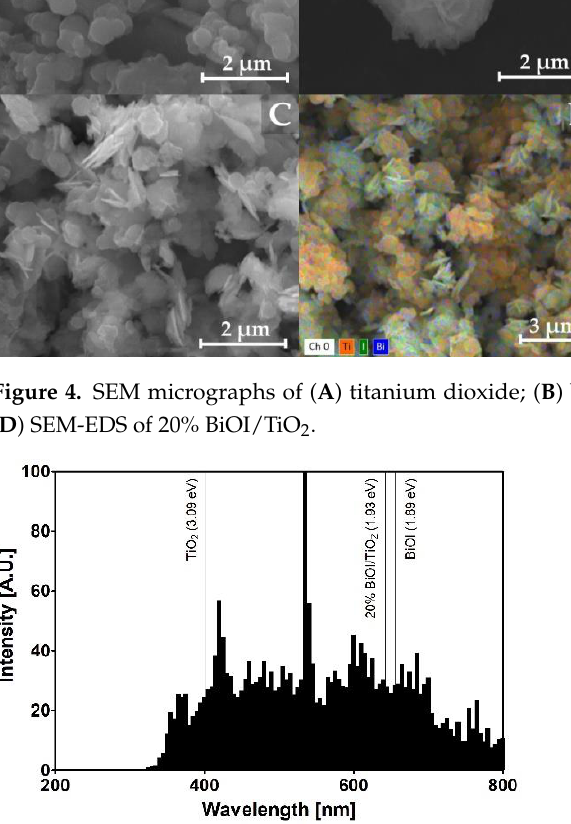
Figure 5. The emission spectrum of the Osram Powerstar HQI – E 400 W/D Pro Daylight lamp (adapted from the spectral distribution reported in the lamp’s datasheet). Vertical lines represent the bandgaps of synthesized photocatalysts.